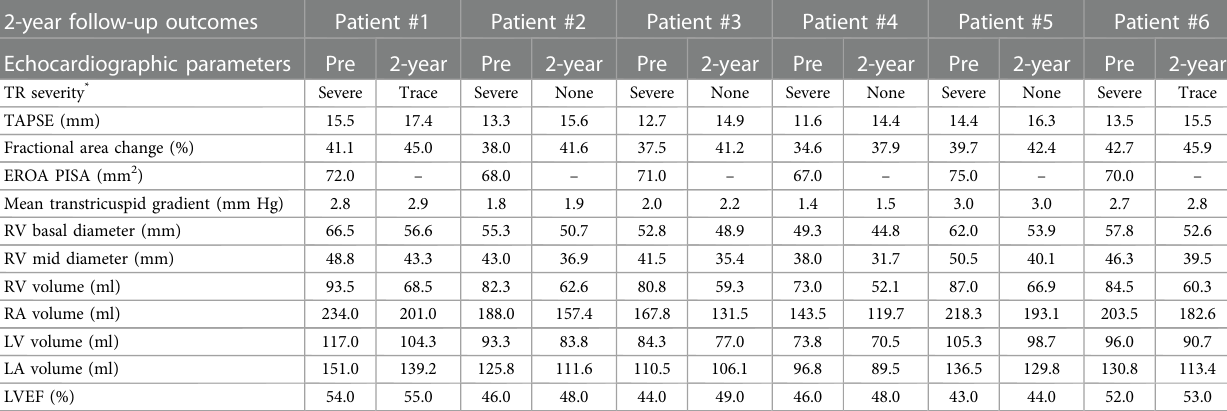
TABLE 5 Baseline to 2-year echocardiographic measurements.